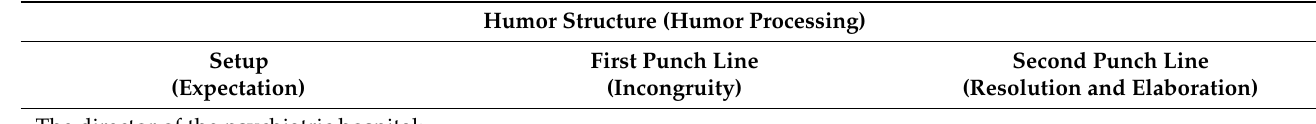
Table 2. An example of a three-element